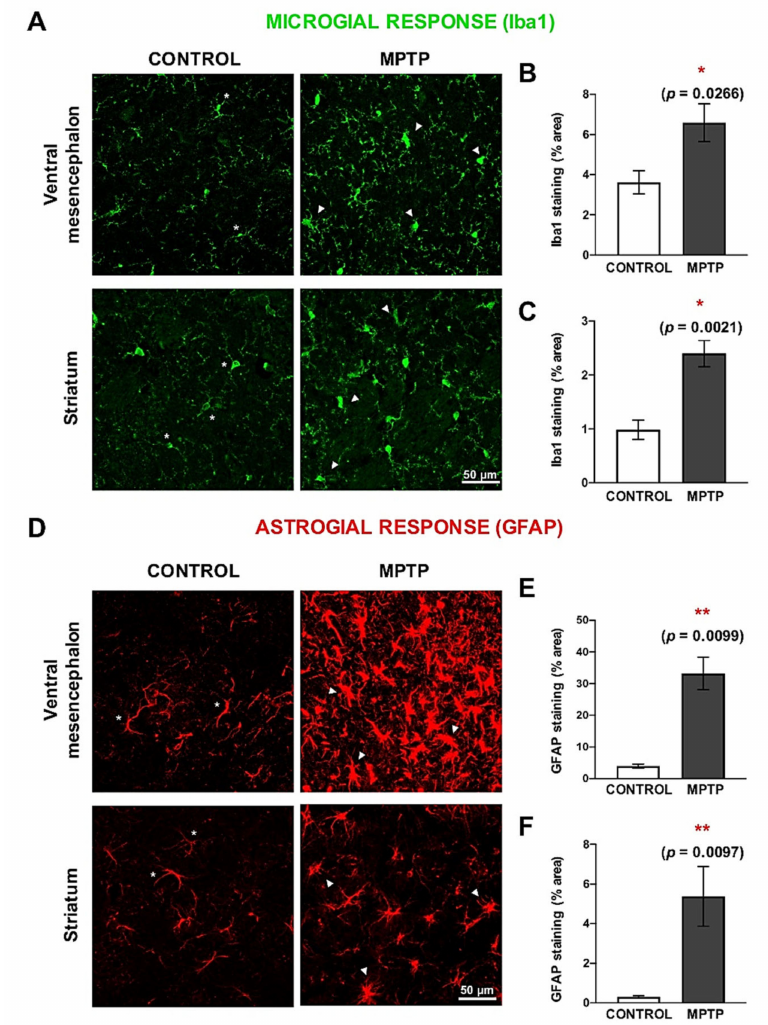
Figure 5. Neuroinflammation is exacerbated both in the ventral mesencephalon and in the striatum of MPTP- Octodon degus . ( A ) Representative microphotographs of microglial response, evaluated by Iba1 immunostaining. ( B ) Quantification of the Iba1 + surface (area expressed as % of the total area) in the ventral mesencephalon and ( C ) in the striatum. ( D ) Representative microphotographs of astroglial response, evaluated by GFAP immunostaining. ( E ) Quantification of the GFAP+ surface area (expressed as % of the total area) of the ventral mesencephalon and ( F ) in the striatum. White asterisks (*) indicate physiological-like morphology, while white triangles ( (cid:52) ) indicate active or hypertrophic morphology. Data are expressed as mean ± SD; * p < 0.05; ** p <